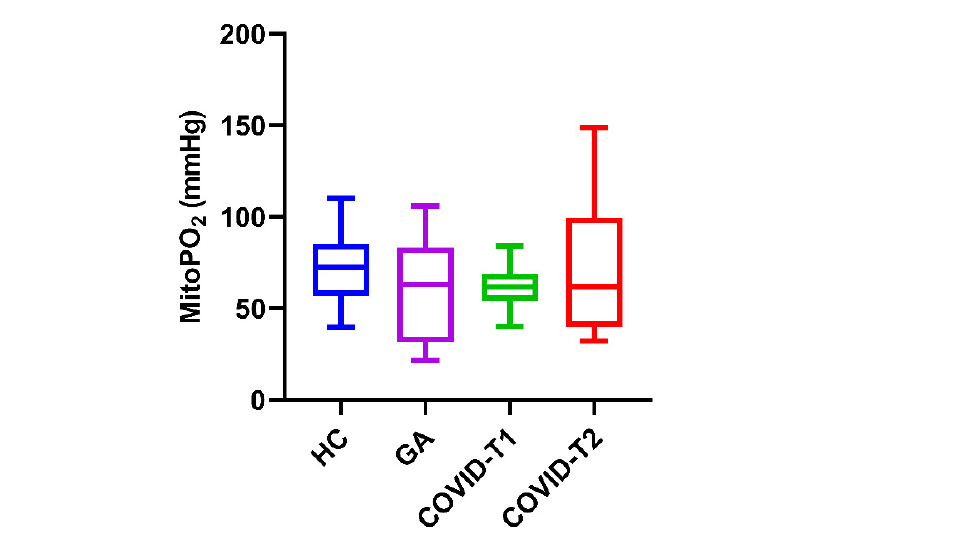
Figure 2. MitoPO 2 (mmHg) in HC, COVID-19 patients on T1 and T2, and general anesthesia group. HC = healthy controls, T1 = time point 1, T2 = time point 2, and GA = general anesthesia. Values are displayed as median with interquartile range (box) and minimum and maximum (whiskers).